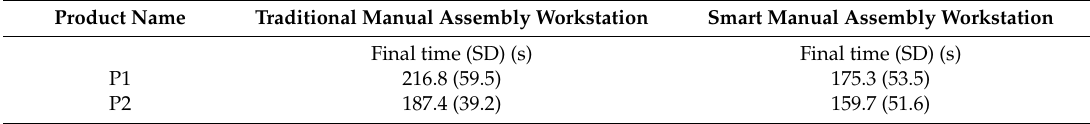
Table 1. Measured times of experiments at traditional and smart manual assembly